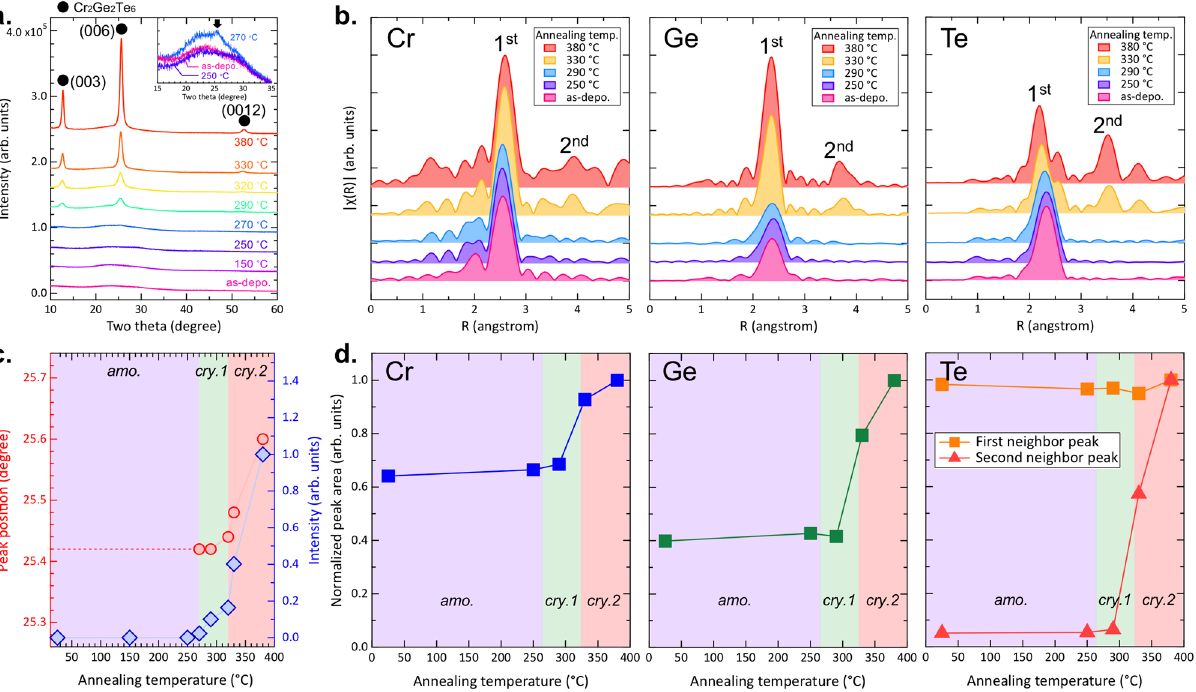
Figure 1. Experimental ( a ) XRD and ( b ) Fourier transformed EXAFS spectra of Cr 2 Ge 2 Te 6 films for different annealing temperatures. Inset of ( a ) shows magnified XRD patterns for the as-deposited, 250 °C-, and 270 °C-annealed films. The onset of crystallization can be confirmed by the appearance of a new peak at 270 °C. Annealing temperature dependence of ( c ) the XRD (006) reflection position and intensity, and ( d ) the peak area of EXAFS spectra for each